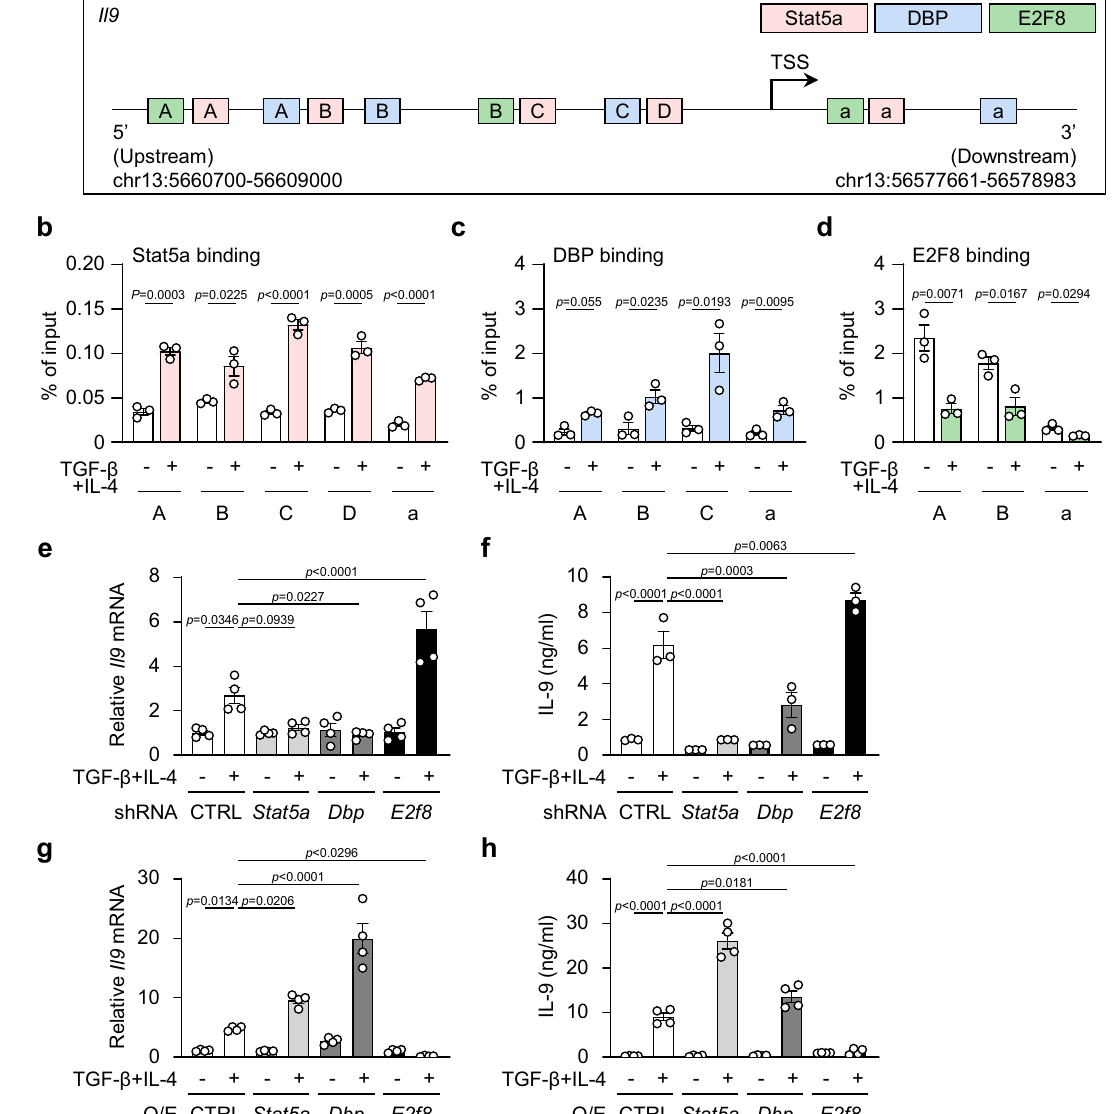
regulation of Dbp and E2f8 in response to TGF- β and IL-4 in CD4 +